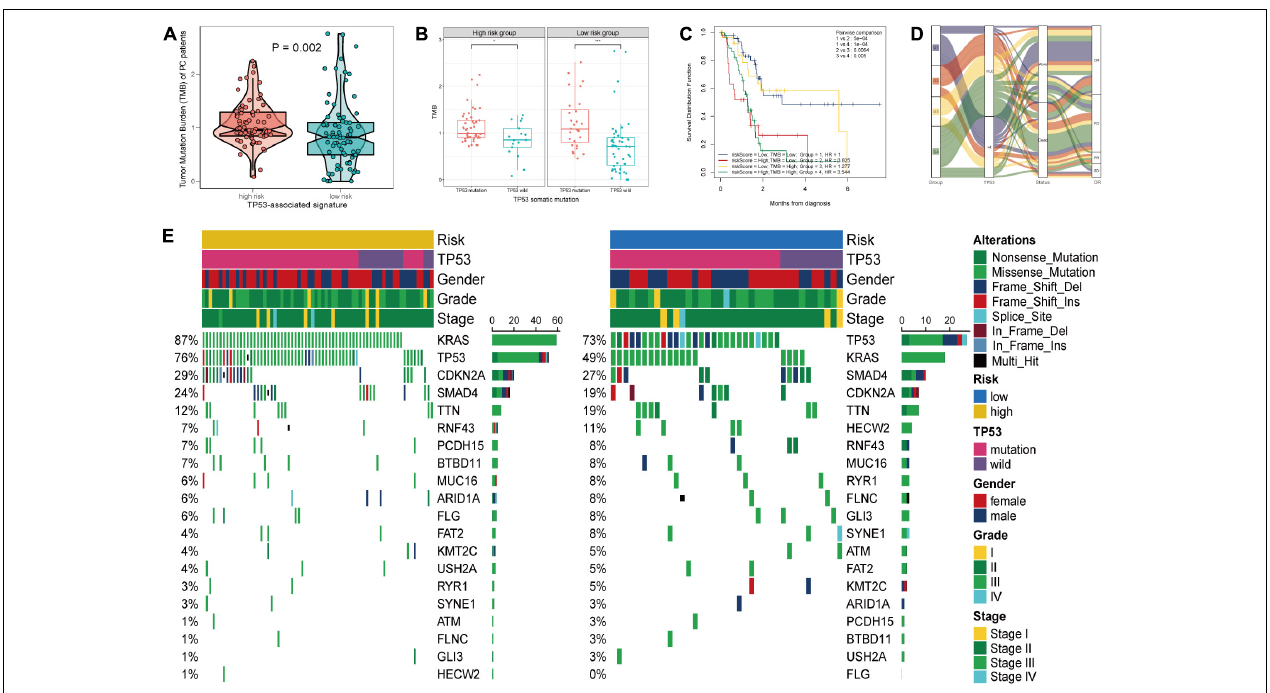
FIGURE 5 | Mutational landscape of the TP53-associated signature. (A) Significant difference of tumor mutation burden (TMB) between patients of high- and low-risk group. (B) Differential TMB between TP53 mutation and TP53 wild-type pancreatic cancer (PC) based on TP53-associated signature. (C) Survival of patients with PC based on the TMB and risk scores. (D) Sankey alluvium showing dynamic correlation of patients with PC. (E) Waterfall plot of somatic mutation displayed mutational landscape correlated with the